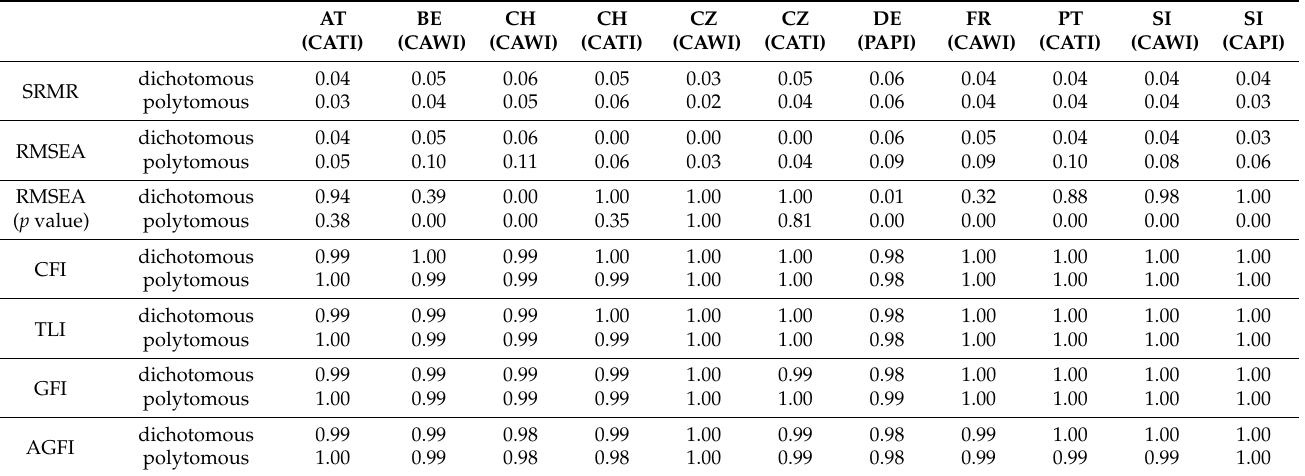
Table 5. Goodness-of-fit indices for two-factor CFA of the HLS 19 -NAV based on dichotomous and polytomous data (based on HLS 19 Consortium [17] (Annex).